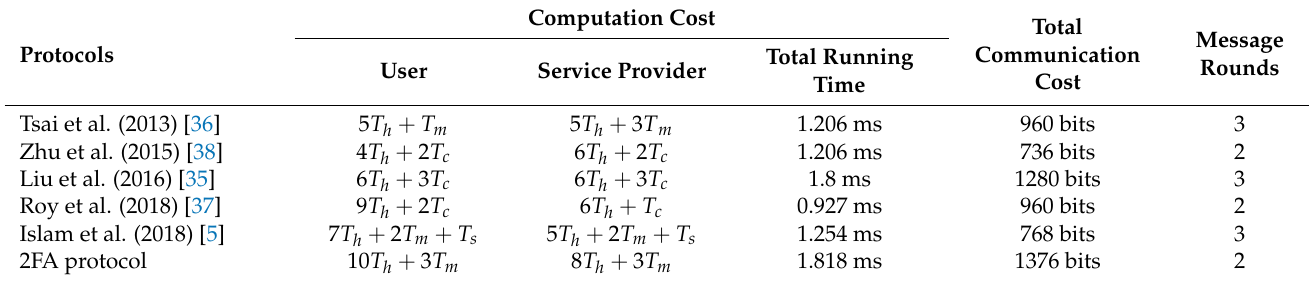
Table 9. Communication and computation costs in the login and authentication